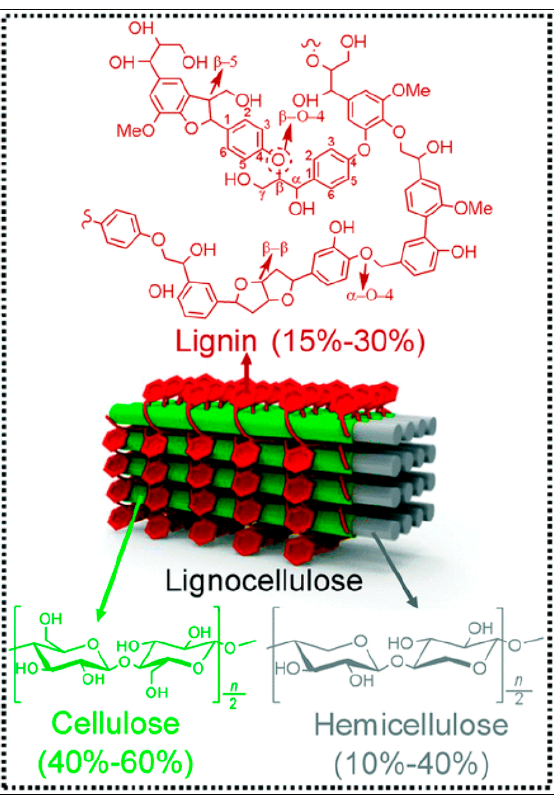
Figure 1. Three main components of lignocellulosic biomass, reproduced with permission from Wu et al., Photocatalytic transformations of lignocellulosic biomass into chemicals, published by Royal Society of Chemistry, 2020. [1].